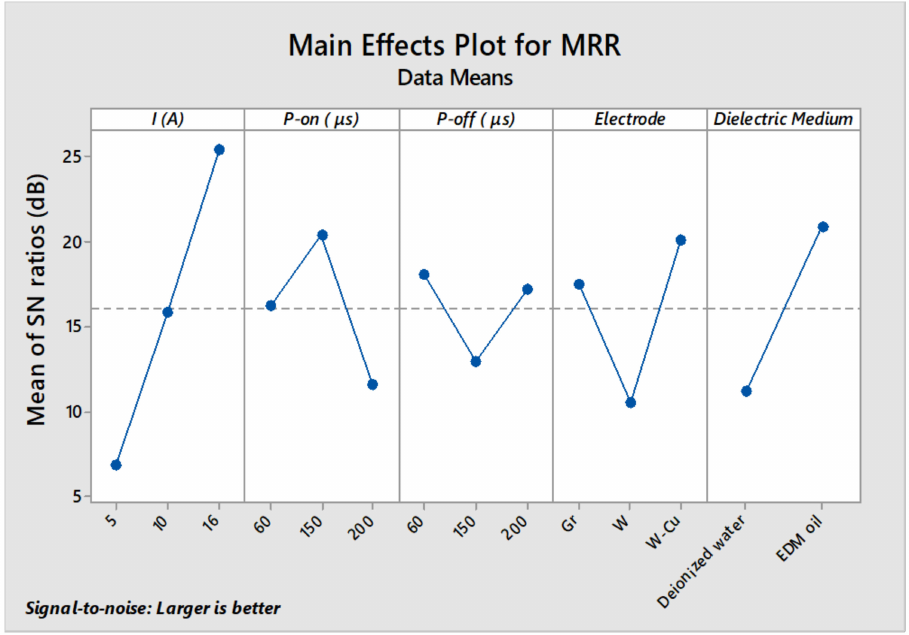
Figure 2. Main e ff ect plot for S / N ratios of Material Removal Rate.